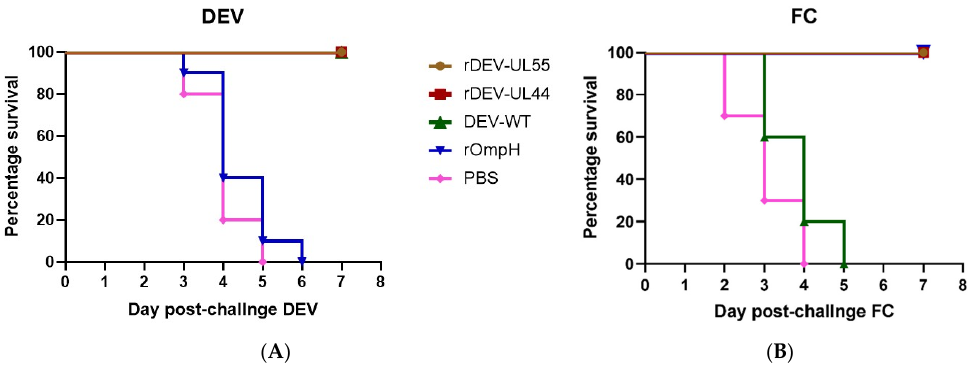
Figure 3. Protective efficacy of the rDEV ‐ UL55 and rDEV ‐ UL44 against virulent DEV ( A ) and P. multocida X ‐ 73 ( B ) challenge in ducks. Ducks were examined daily for 1 week after challenge. 3.4. Detection of IFN ‐γ and IL ‐ 4 in Serum as the Cellular Response to Recombinant DEV ‐